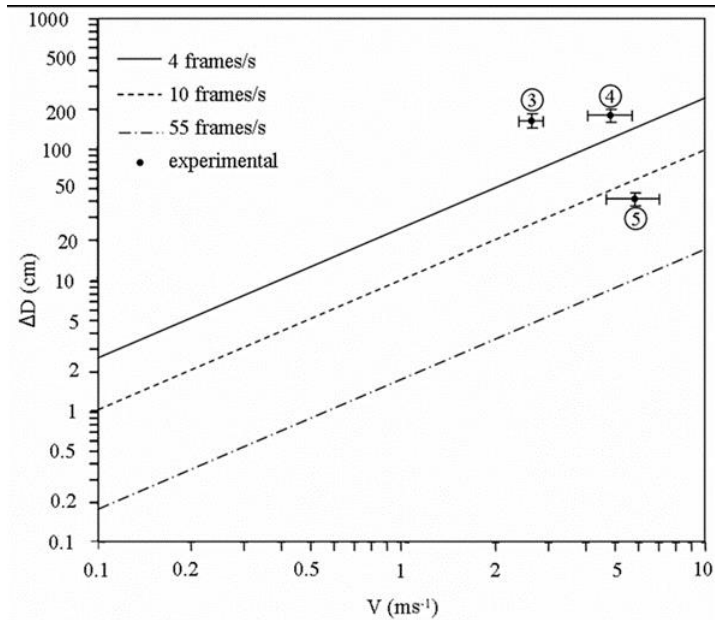
Figure 9. Evolution of the sample length extension ∆ D as a function of the solids velocity V for three different acquisition rates. Experimental values corresponding to the ones enumerated in Figure 4 are also shown together with uncertainty bars.